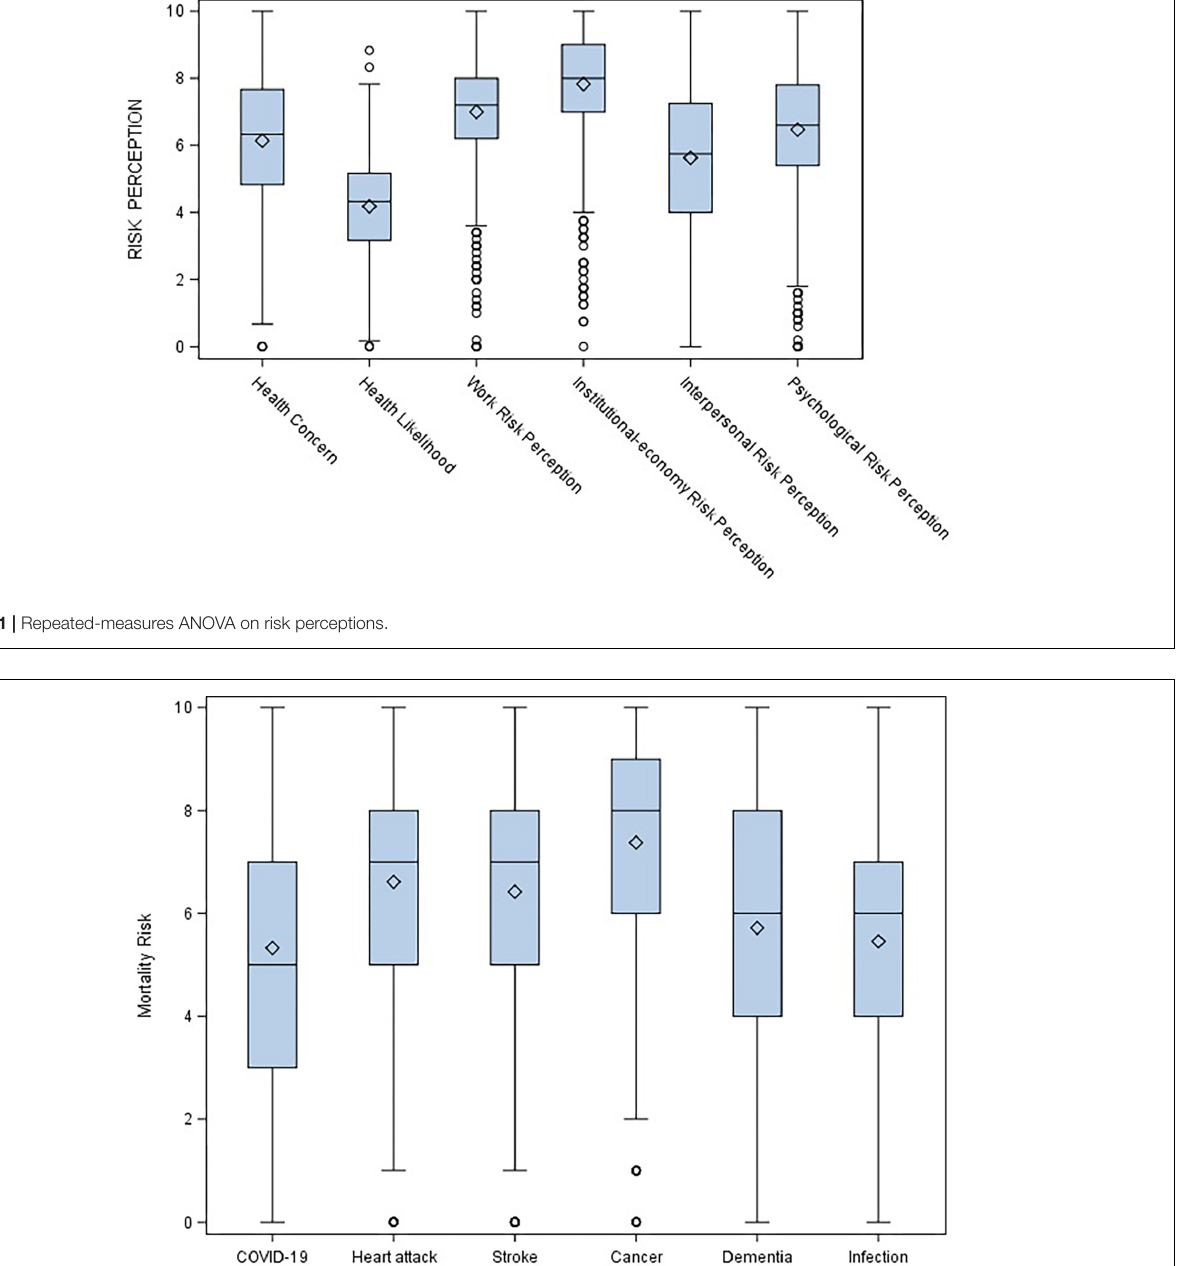
but also to positive feelings. Anxiety and uncertainty are strongly related to each